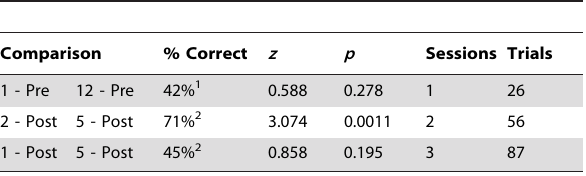
Table 4. Bioassay results of unrewarded generalization trials (pair-wise, between-subjects comparisons of feces).